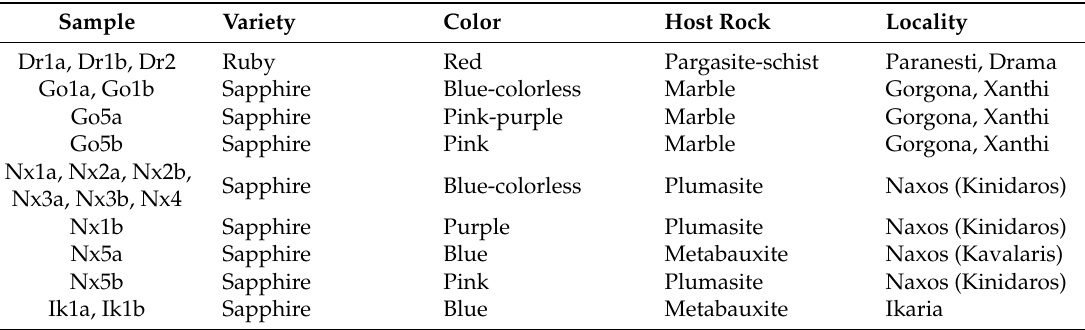
Table 1. Sample description of the studied Greek corundum